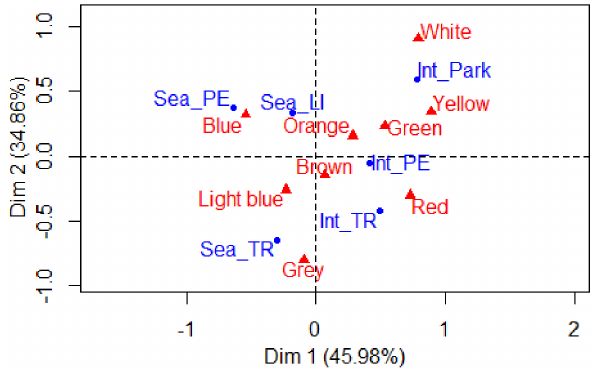
Figure 7: Correspondence analysis between colours and types of area. Blue dots represent the type of area and red triangles the colour associated to the soundscape.